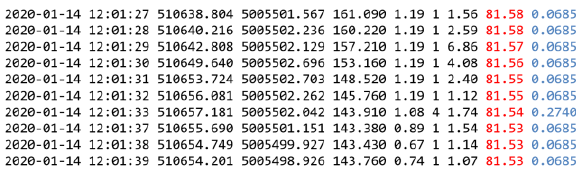
Figure 19. The same example-data above with two more columns added: air pollution (in our case PM 10; unit is in μ g/m3; it is shown in red) and personal exposure (PM 10, units are absolute μ g and are shown in blue)